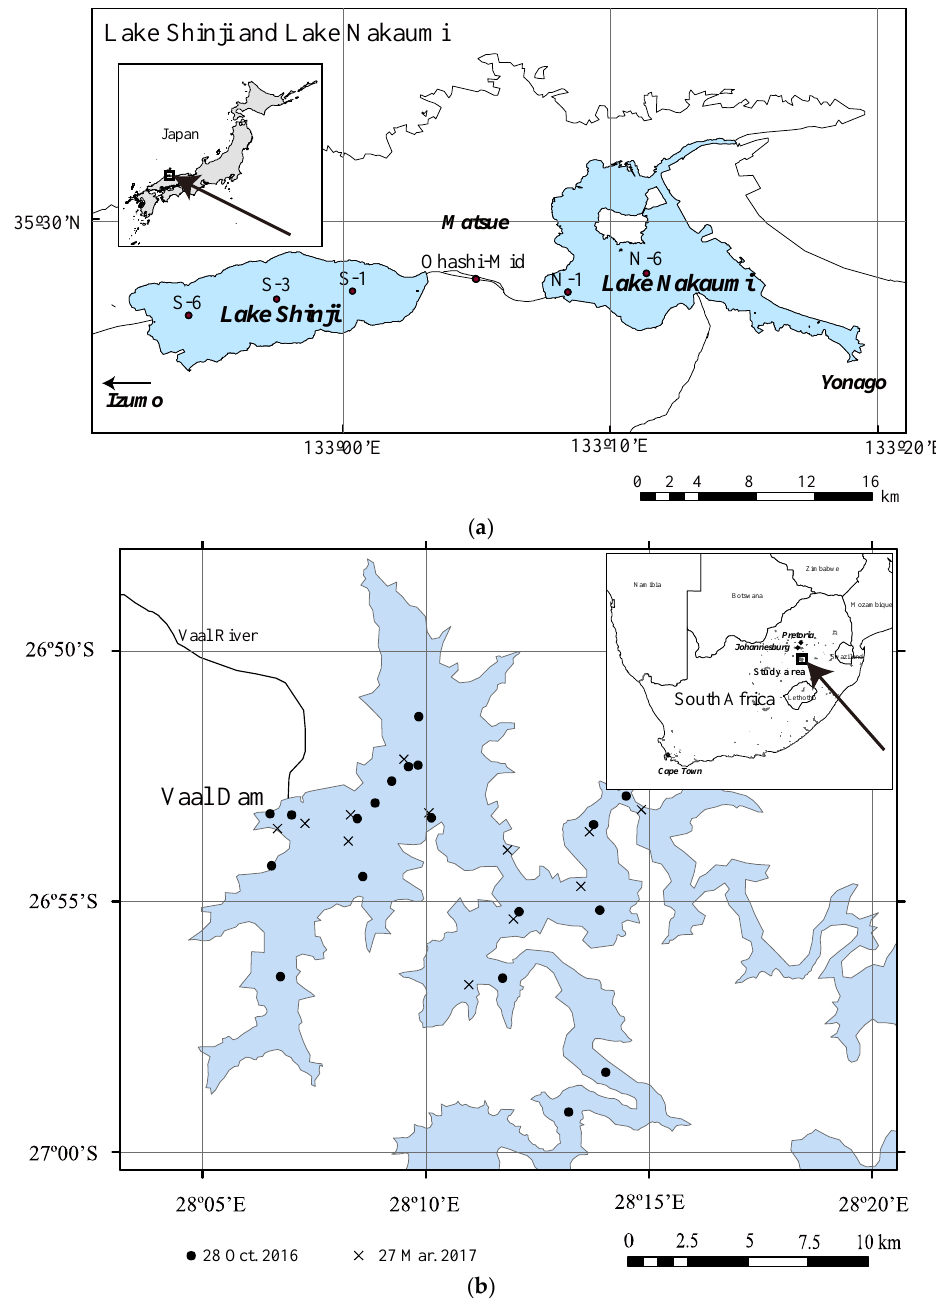
Figure 2. Study areas and field observation points. ( a ) Lake Shinji and Lake Nakaumi (SJNU); ( b ) Vaal Dam Reservoir (VDR).